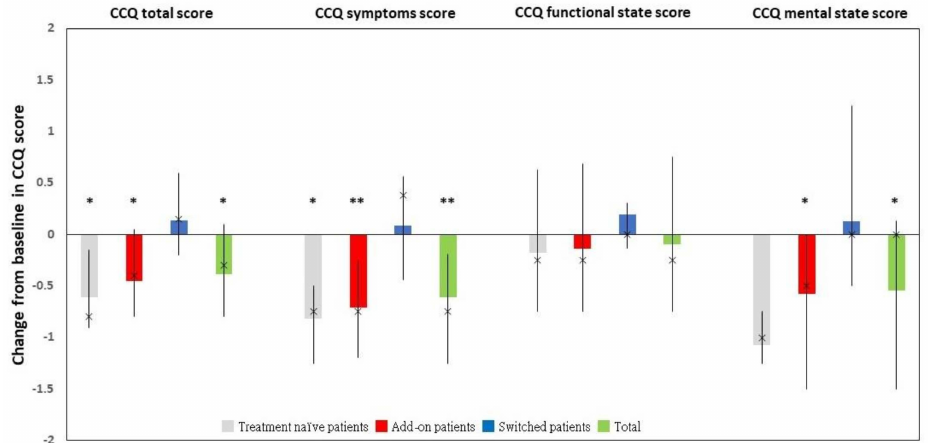
Figure 2. The change from baseline in CCQ total and domain scores in the full analysis dataset and its corresponding subgroups. * p < 0.05. ** p < 0.001. Abbreviations: CCQ, clinical COPD questionnaire.